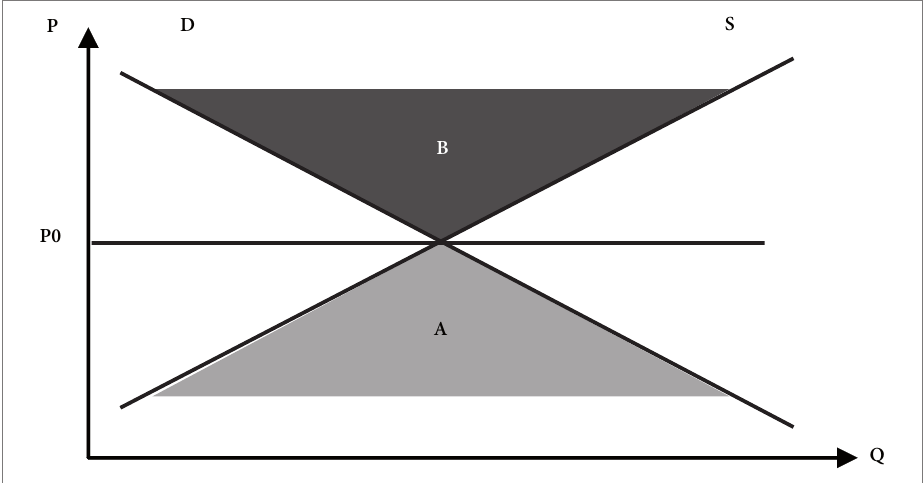
Fig. 2. Demand and supply equilibrium